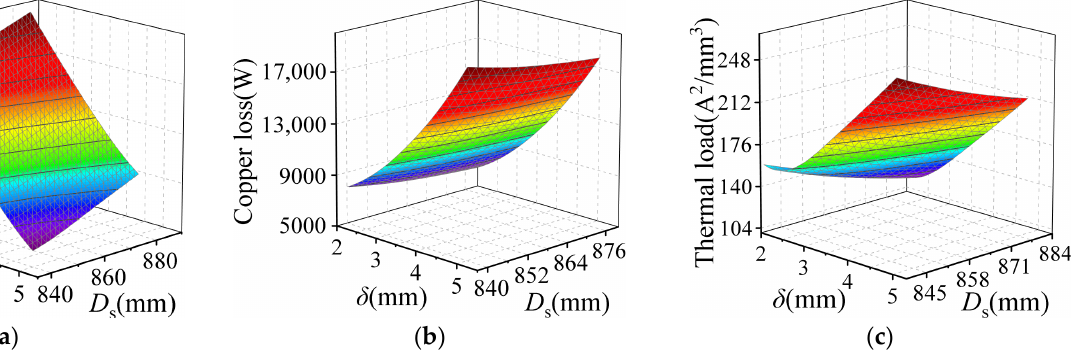
Figure 8. Response surface of core length and stator outer diameter to electromagnetic performance parameters. ( a ) Efficiency; ( b ) back EMF; ( c ) core loss.